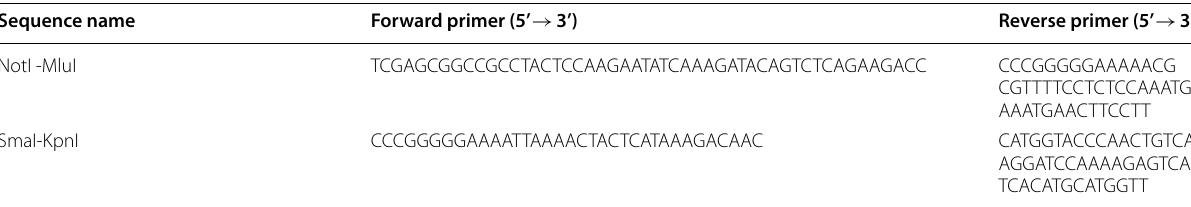
Table 2 The primers of pSC3-MCS